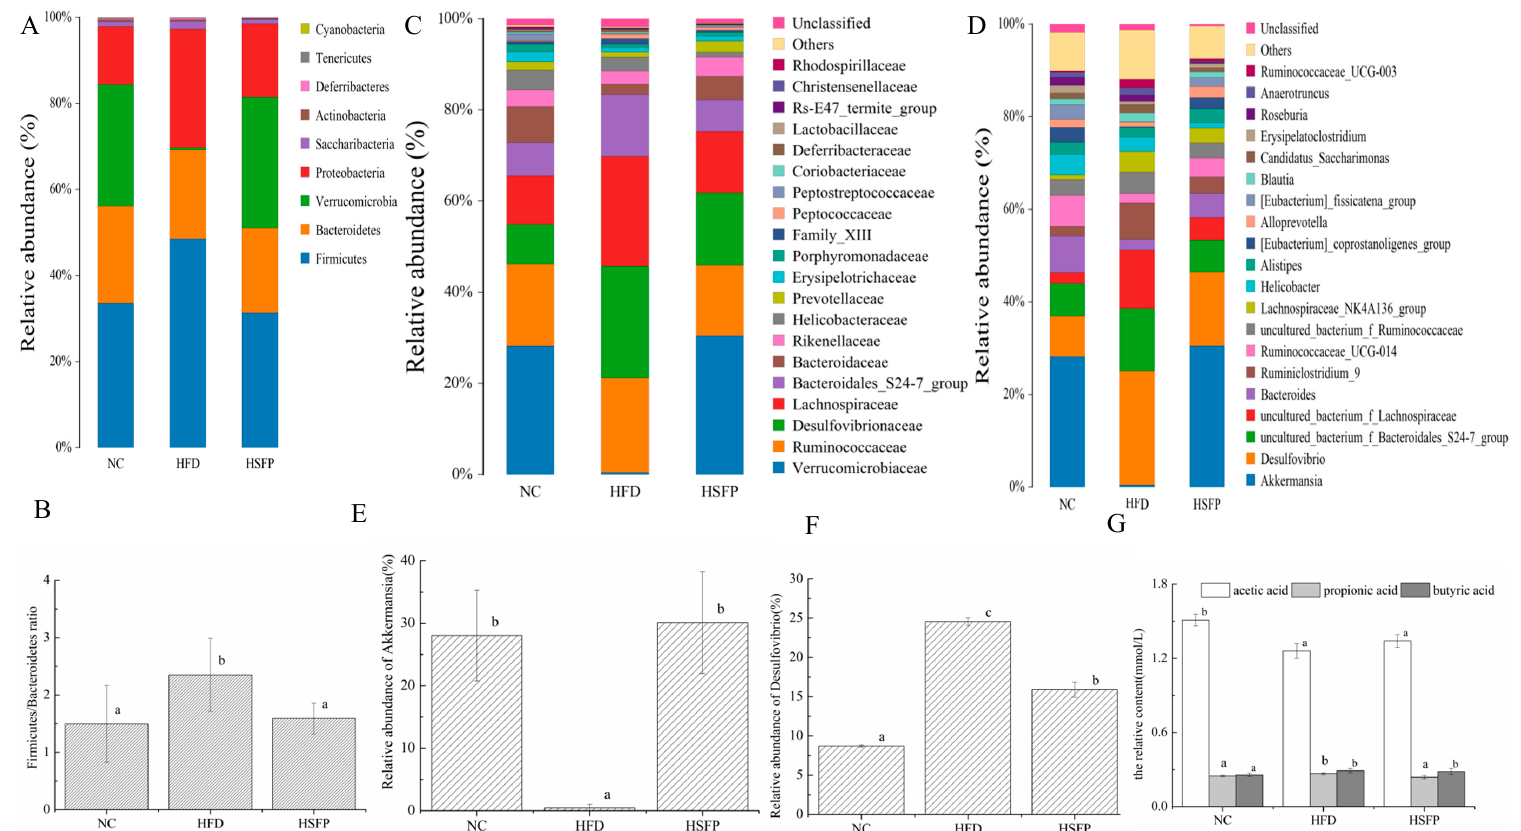
Figure 4. Seabuckthorn freeze-dried powder administration alters the composition and structure of gut microbiota. The composition and proportion of bacterial communities at the phylum ( A , B ), family ( C ) , and genus ( D ) level. Specific genus of bacteria ( E ); Akkermansia ( F ); Desulfovibrio ( G ). The relative abundance of short-chain fatty acids (SCFAs) in three groups. Data were shown as means ± SD. Graph bars with different letters on the top correspond to statistically significant results ( p < 0.05) based on one-way ANOVA analysis followed by Duncan’s multiple range test.